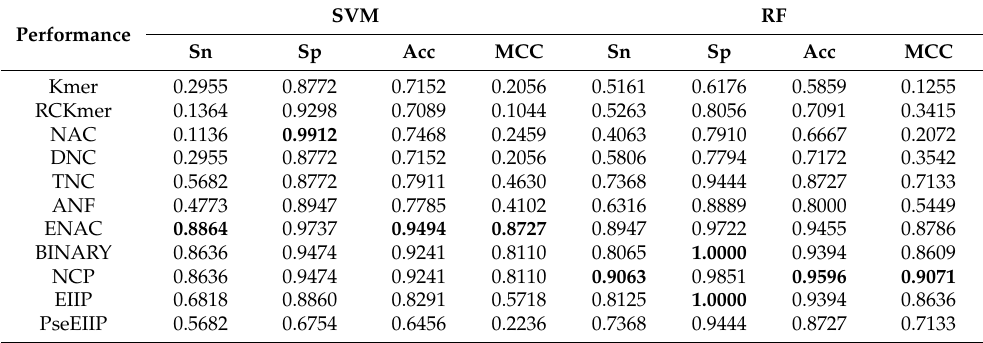
Table 1. Performance of different sequence encoding schemes using SVM and RF in independent tests.